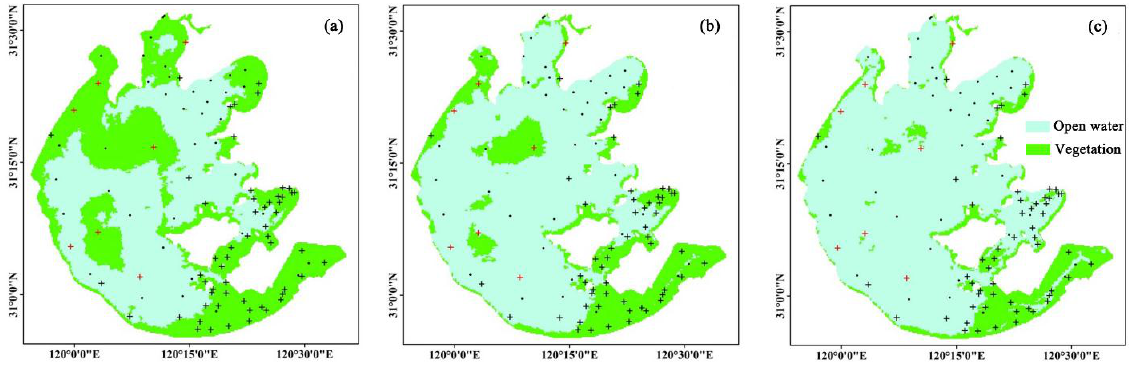
Figure 5. Variation in the area classified as vegetation signal on 8 October 2013 with FAI thresholds of ( a ) −0.04, ( b ) −0.025 and ( c ) −0.004. Aquatic vegetation at the locations is denoted by black crosses, and thick floating algal blooms are denoted by red crosses. The black dots denote locations of open